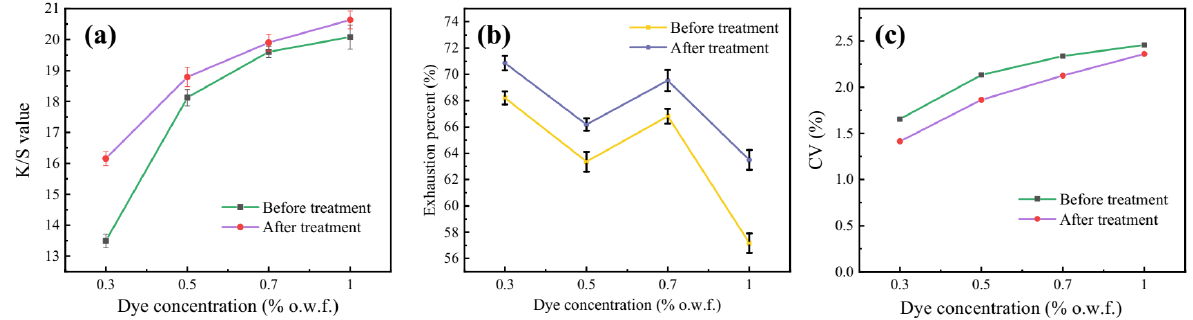
Figure 3. Exhaustion percent ( a ) of dye, K / S value ( b ) and color uniformity ( c ) CV% of dyed fabrics before and after extraction.